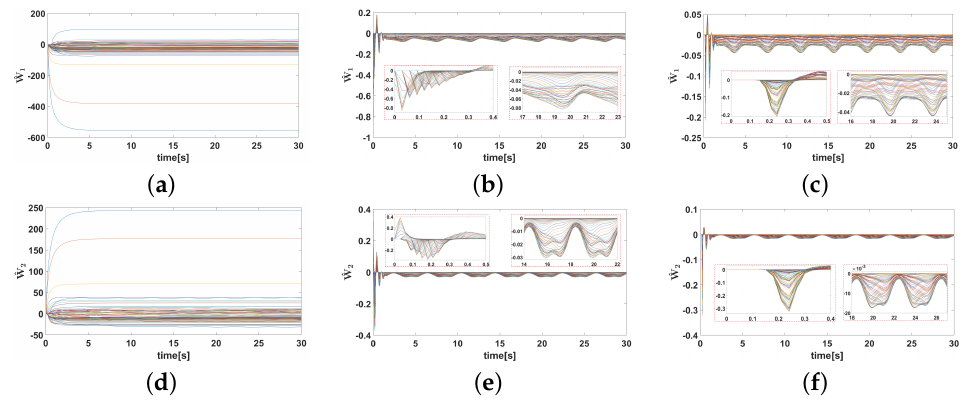
Figure 11. The weight of two joints based on the CLIRBFNN, IRBFNN, and RBFNN. ( a – c ) show the weights of Joint 1. ( d – f ) show the weights of Joint 2.